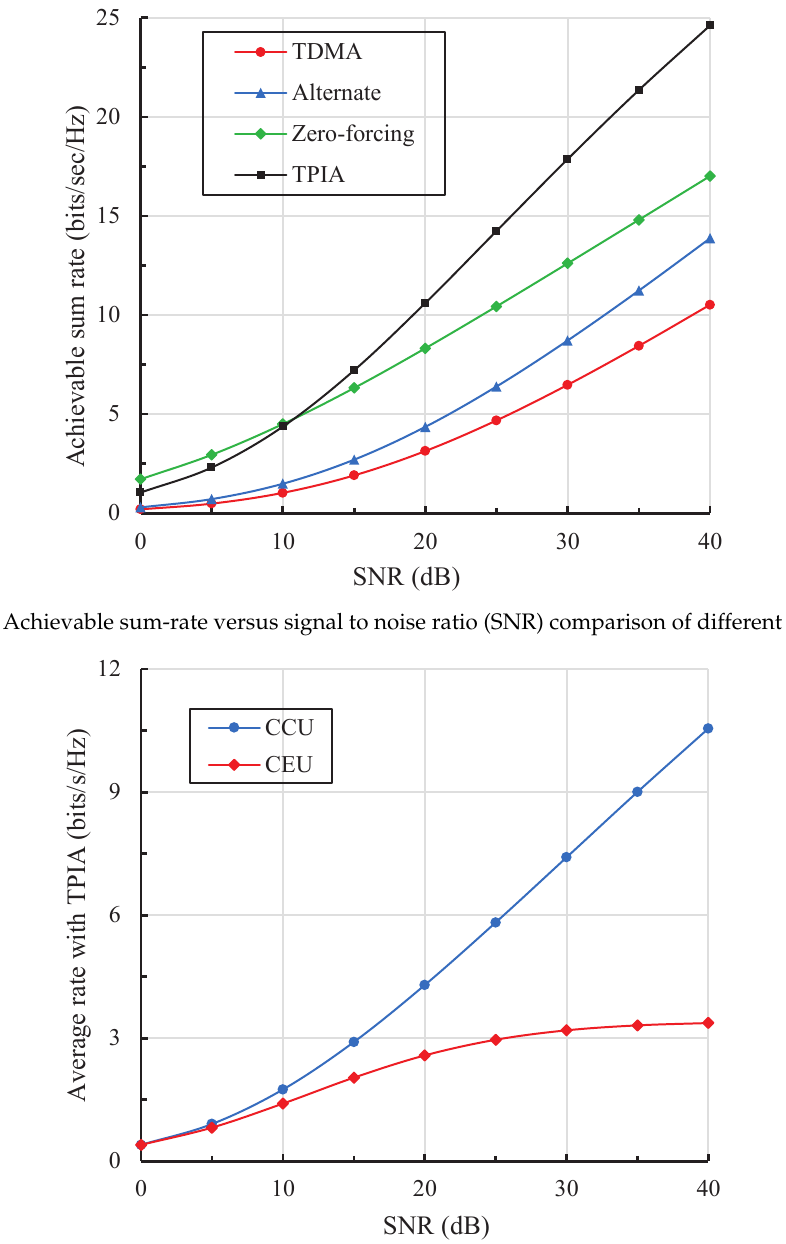
Figure 3. Average rate comparison under TPIA between cell-center user (CCU) and cell-edge user